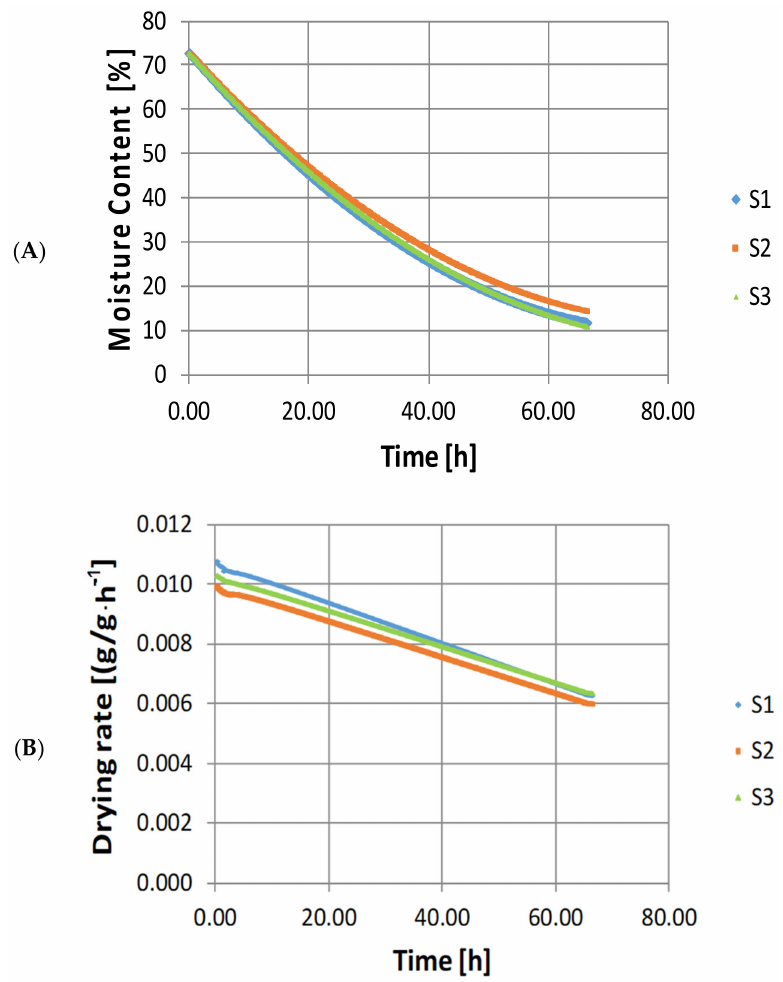
Figure 4. Curves of moisture content MC t ( A ) and drying rate DR t ( B ) as a function of time for sage dehydration process. Data are means of three replications (S1 = 3 kg / m 2 ; S2 = 4 kg / m 2 and S3 = 5 kg / m 2